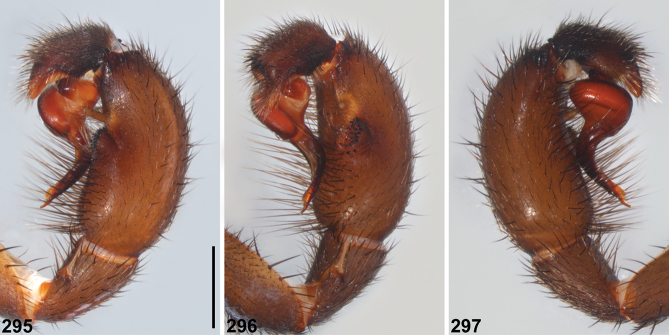

Idiosoma
mcclementsorum sp. n., male holotype (WAM T139471) from Julimar Conservation Park (Western Australia; JAF), pedipalp. 295 Retrolateral view 296 Retroventral view 297 Prolateral view. Scale bar 2.0.